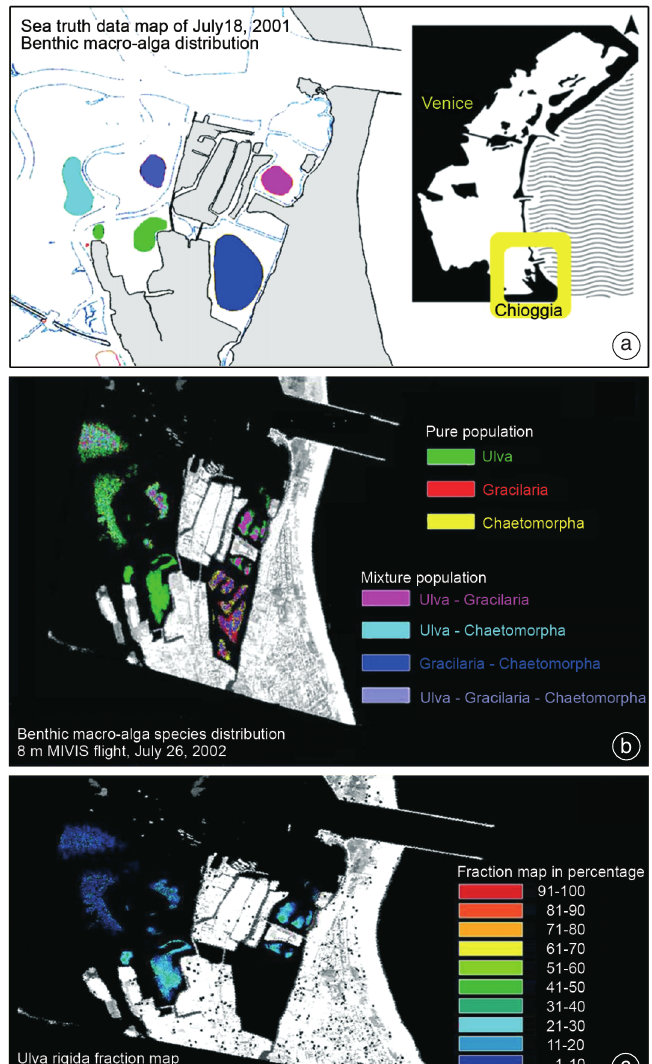
Fig. 2a-c. Subpixel classification results for the Chioggia city areas superimposed on the MIVIS spectral band of 1500-1550 nm. a) Sea truth data map; b) benthic macro-alga species distribution; c) Ulva rigida fraction